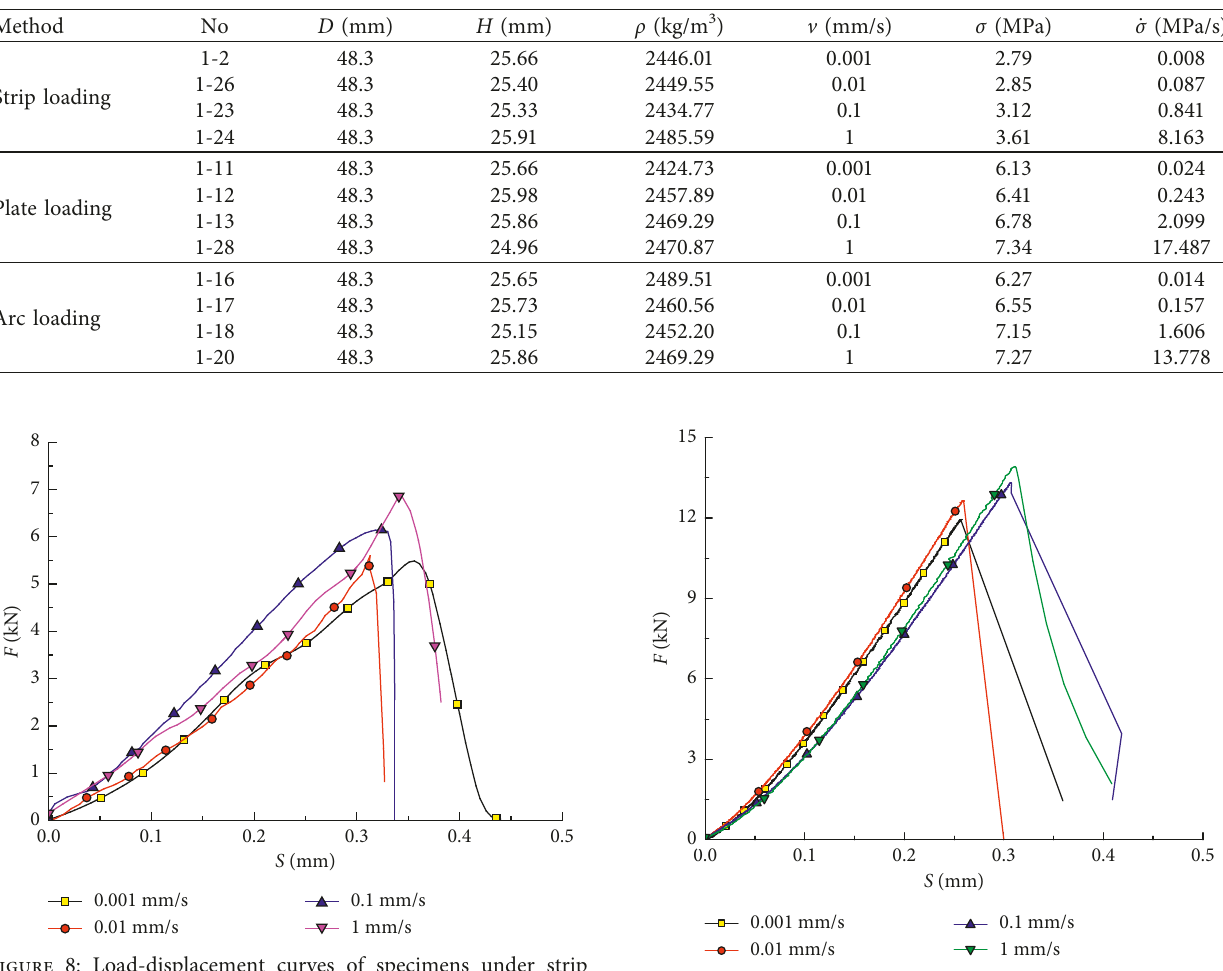
Table 2: Parameters of the specimens from the indirect tensile tests.